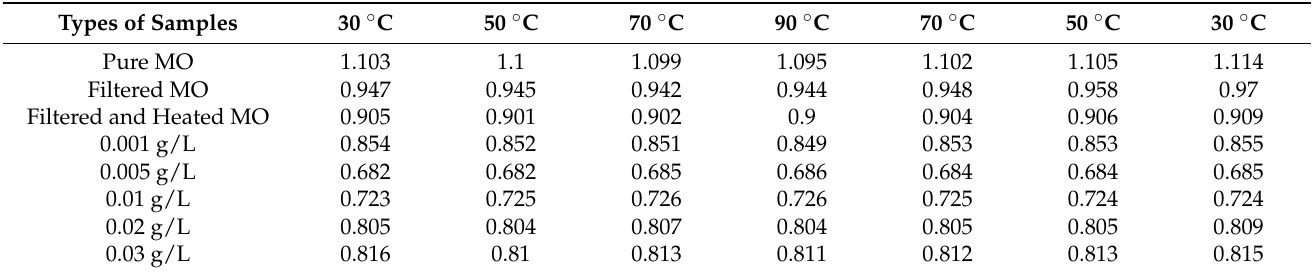
Table 5. Value of relative permittivity of different types of samples with temperature increasing from 30 ◦ C to 90 ◦ C and falling to 30 ◦ C.